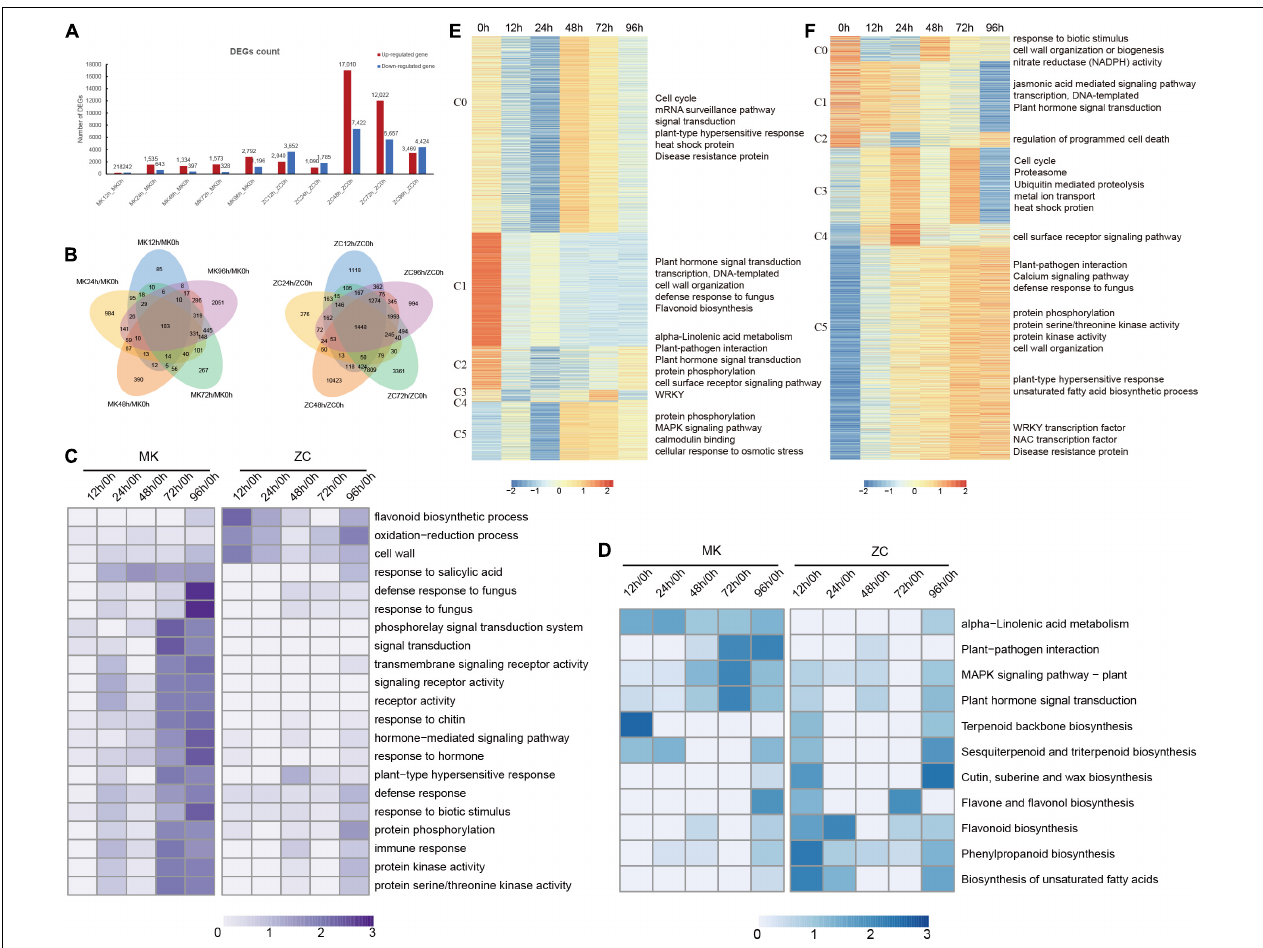
FIGURE 1 | Statistical and functional analysis of differentially expressed genes (DEGs) in MK and ZC during infection. (A) Number of upregulated and downregulated DEGs at different time points compared to 0 h in MK and ZC. (B) Venn diagrams of the different comparison of MK and ZC. (C,D) GO term (C) and KEGG pathway (D) enrichment of DEGs in pairwise comparisons in MK and ZC. Z-score value of normalized –log 10 ( p -value) of each item was used to draw heatmap. (E,F) gene expression pattern and function of DEGs in ZC (E) and MK (F) . Z-score value of normalized FPKM of gene was used to draw heatmap. GO and KEGG enriched function item are showed on the